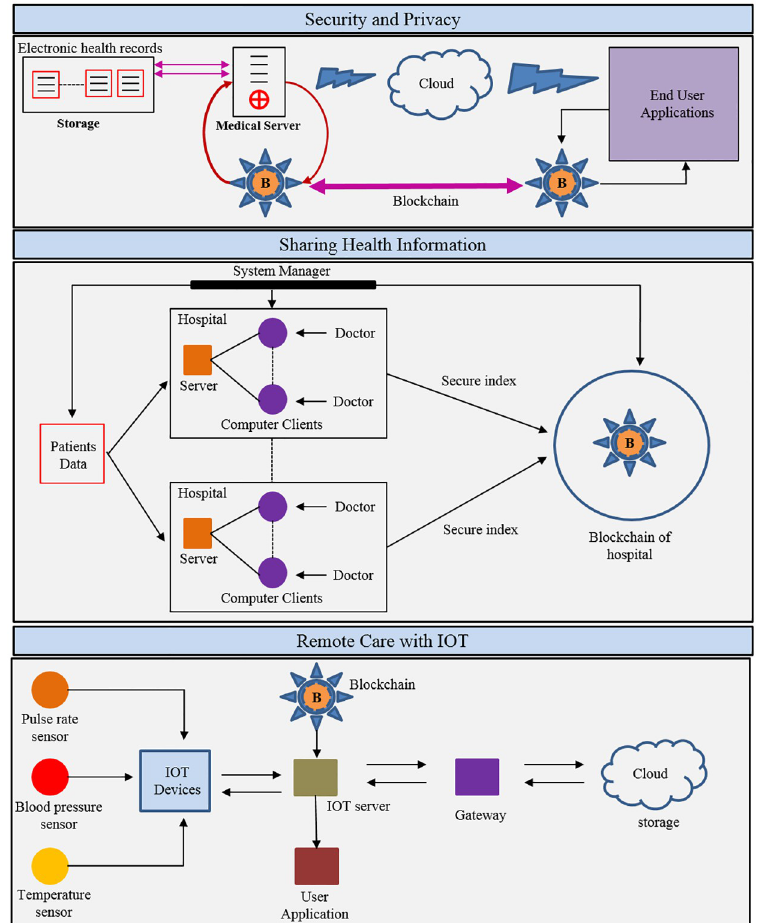
Fig 5. Major healthcare domains where BCT has been used.